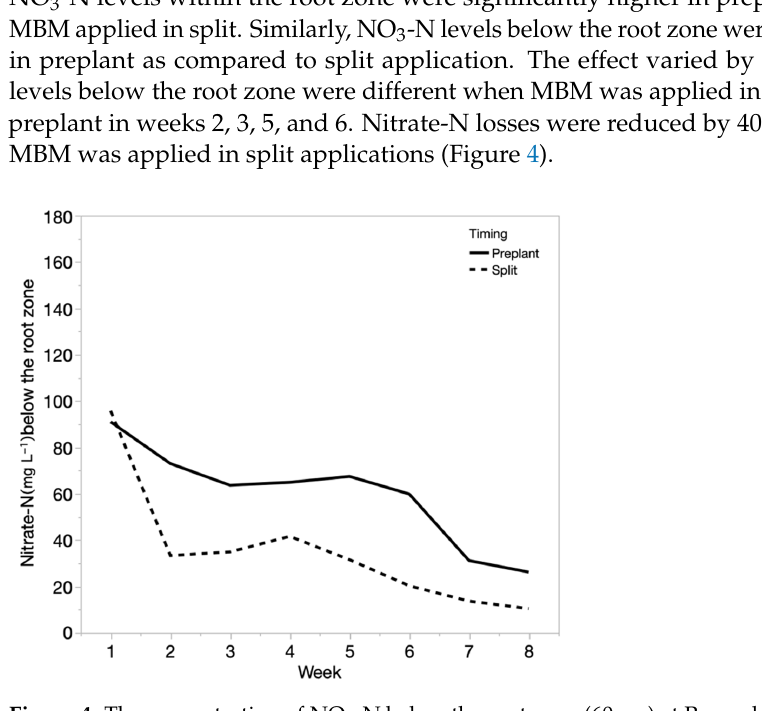
Figure 4. The concentration of NO 3 -N below the root zone (60 cm) at Poamoho throughout the study period for the application timing (preplant and split) of meat and bone meal. period for the application timing (preplant and split) of meat and bone